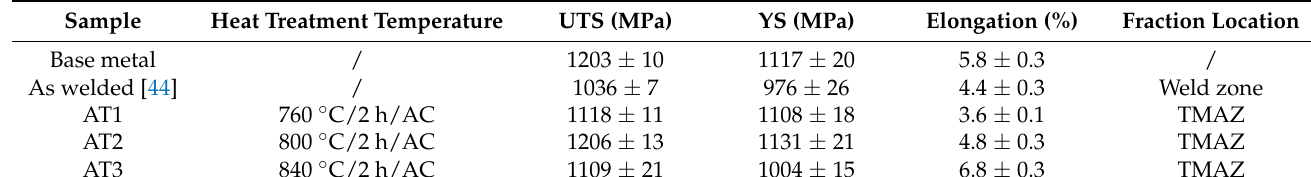
Table 5. Profiles of tensile tests under different aging treatment conditions.